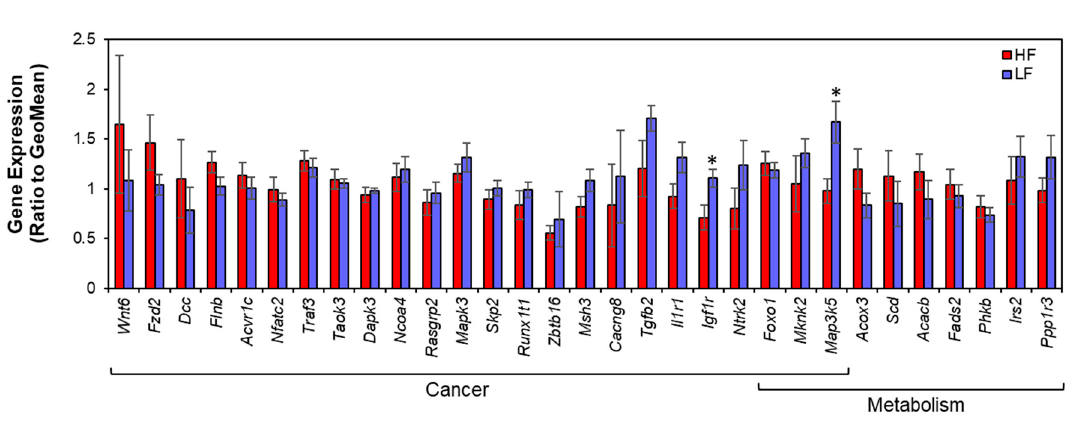
Figure 5. Gene expression in cancer and metabolism genes. Gene expression values are normalized to the geometric mean of Actb , Gapdh , and Rpl7a . * p < 0.05.